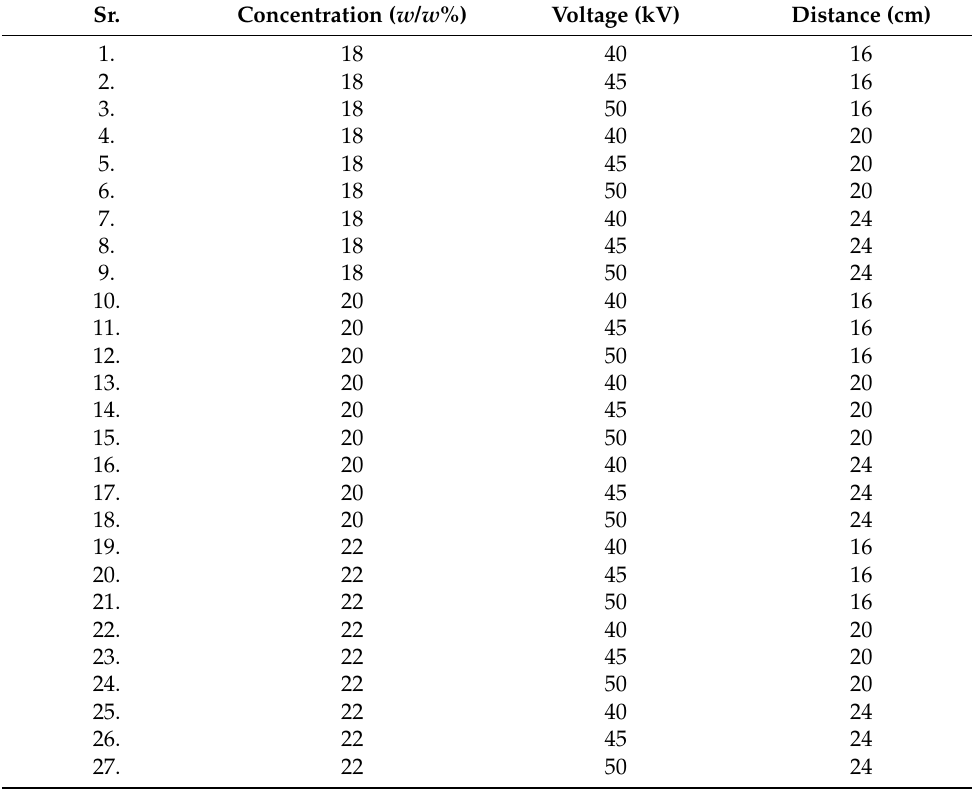
Table 1. Optimization of electrospun nanofibers of PA.